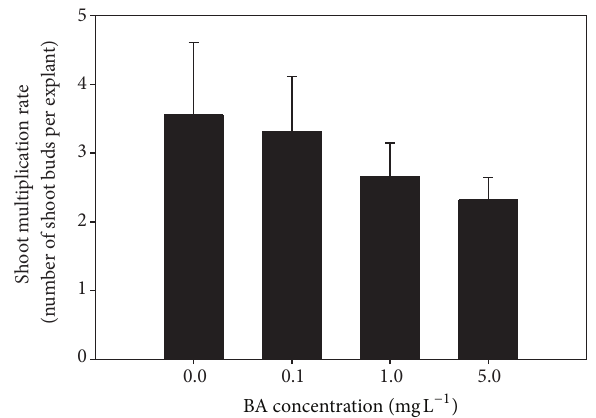
Figure 5: Relationship between DPPH scavenging activity and total soluble phenolic contents in C. heterophyllus shoots cultured for 4 weeks in MS/2 liquid media supplemented with different BA concentrations. Values represent means ± standard